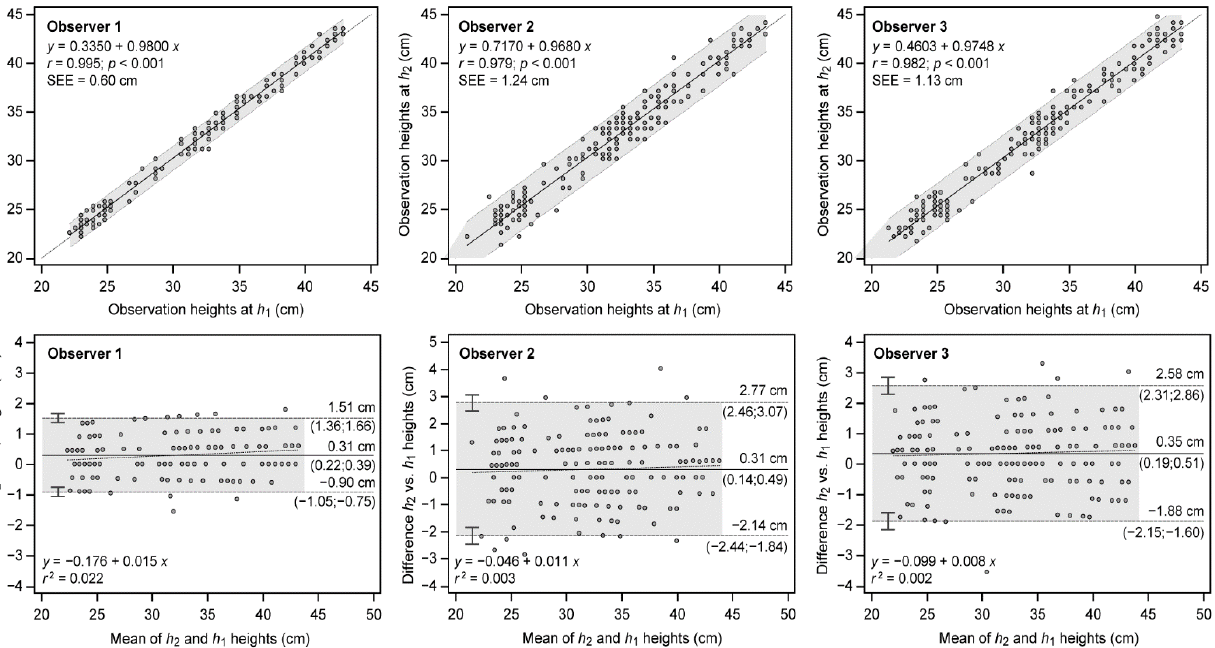
Figure 3. Agreement between methods derived from observers 1, 2, and 3. Relationship between observations ( top ) and Bland–Altman plots ( down ) are shown. For regression, dotted line represents linear regression; upper and lower dashed lines show 95% confidence intervals. Predictive linear regression equations, Pearson’s product-moment correlation coefficient ( r ) and standard error of estimate (SEE) are also depicted. For Bland–Altman, solid central line represents the mean between observations (systematic bias); upper and lower dashed lines show mean ± 1.96 SD (random error) with CI-95% limits in parenthesis; dotted line depicts linear regression (proportional bias).